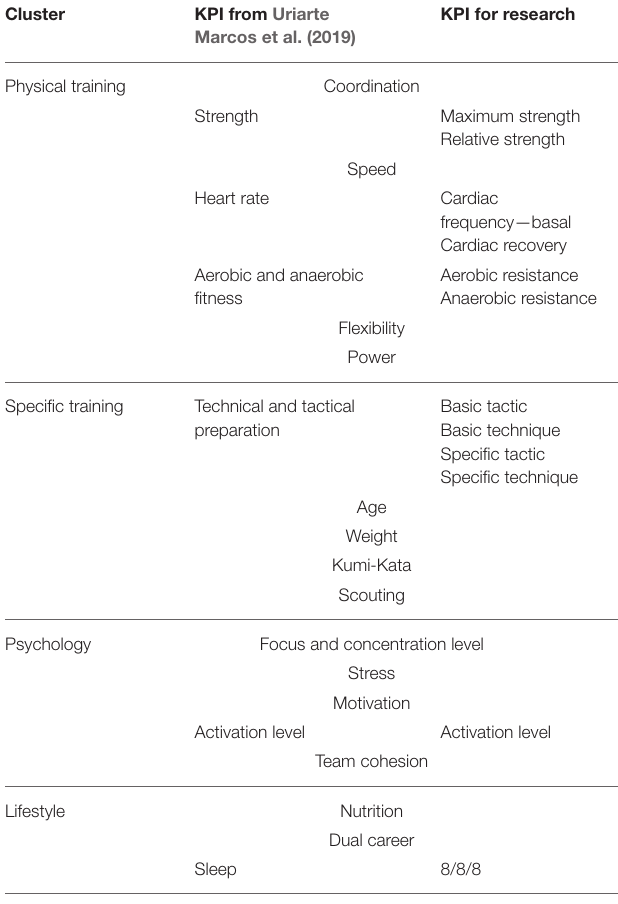
TABLE 2 | Selection of the judo KPI and clusters. Cluster KPI from Uriarte KPI for Marcos et al. (2019)